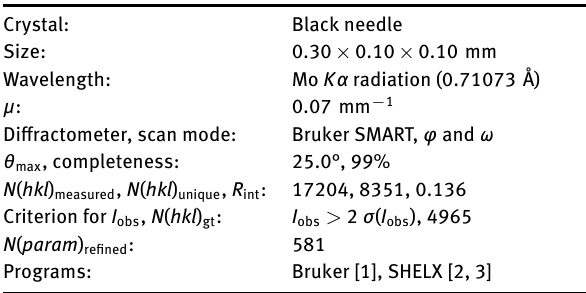
Table 1: Data collection and